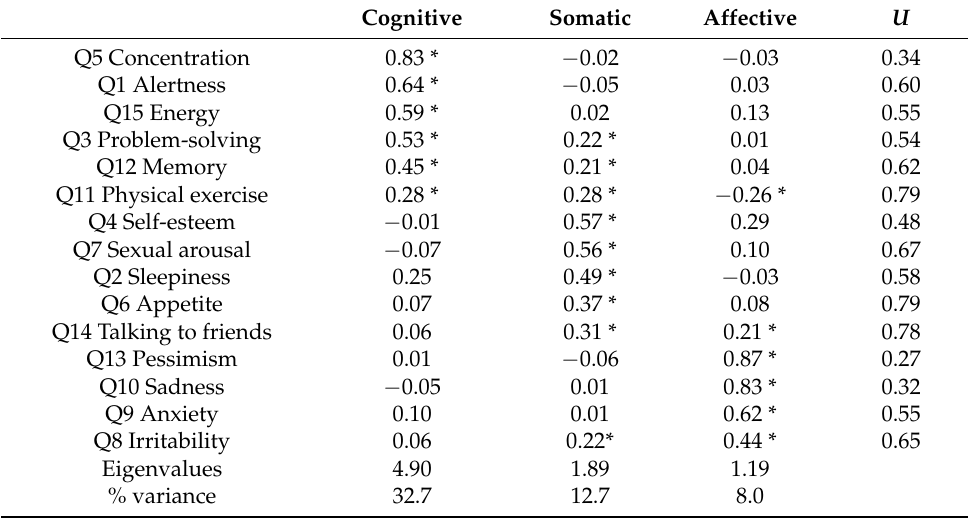
Table 1. Factor analysis considering the whole